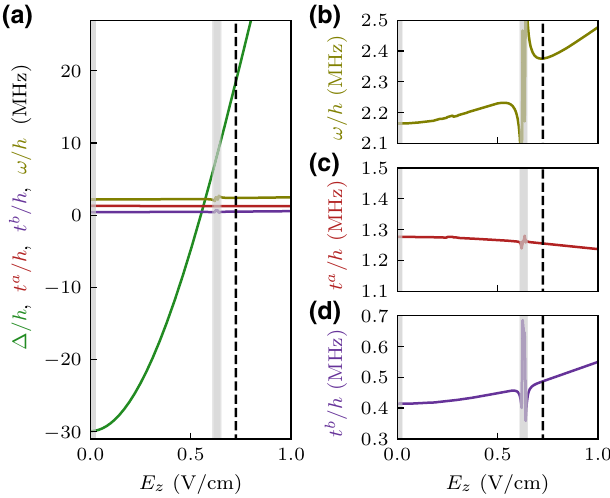
FIG. 6. The dependence of the parameters of the Hamiltonian on the electric field. (a) The energy difference (cid:3) depends strongly on the electric field E z through the Stark effect. In comparison, the nearest-neighbor-hopping amplitudes only weakly depend on E z . The dashed lines indicate the value of E z = 0.725 V / cm that is used throughout the paper. Note that for some other values, other Rydberg pair states become resonant and are admixed to the states of the V -structure (the gray regions indicate an admixture > 5%). There, our perturbative calculation of the hopping ampli- tudes is no longer valid. (b)–(d) Close-up views of the electric field dependence of the nearest-neighbor-hopping